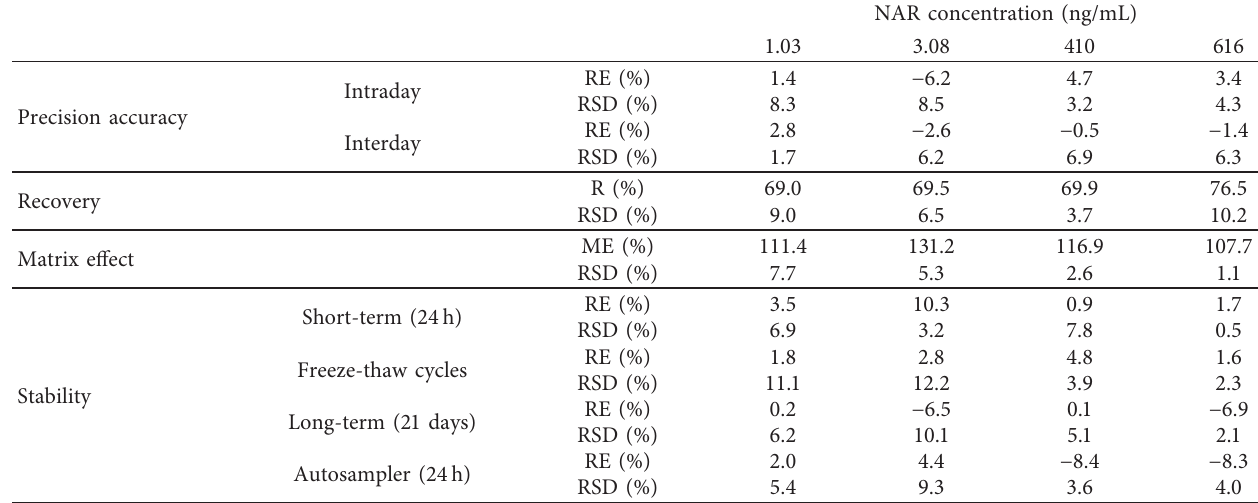
Table 2: Method validation of NAR in rat plasma ( n � 6).